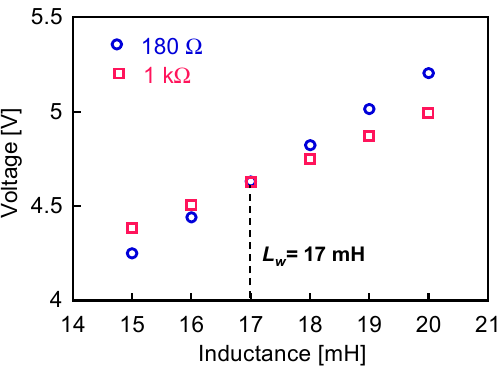
Figure 7. Peak values of intrinsic pulse voltage, V in , as functions of internal inductances of the Wiegand sensor. Load resistor R was either 180 Ω or 1 k Ω .